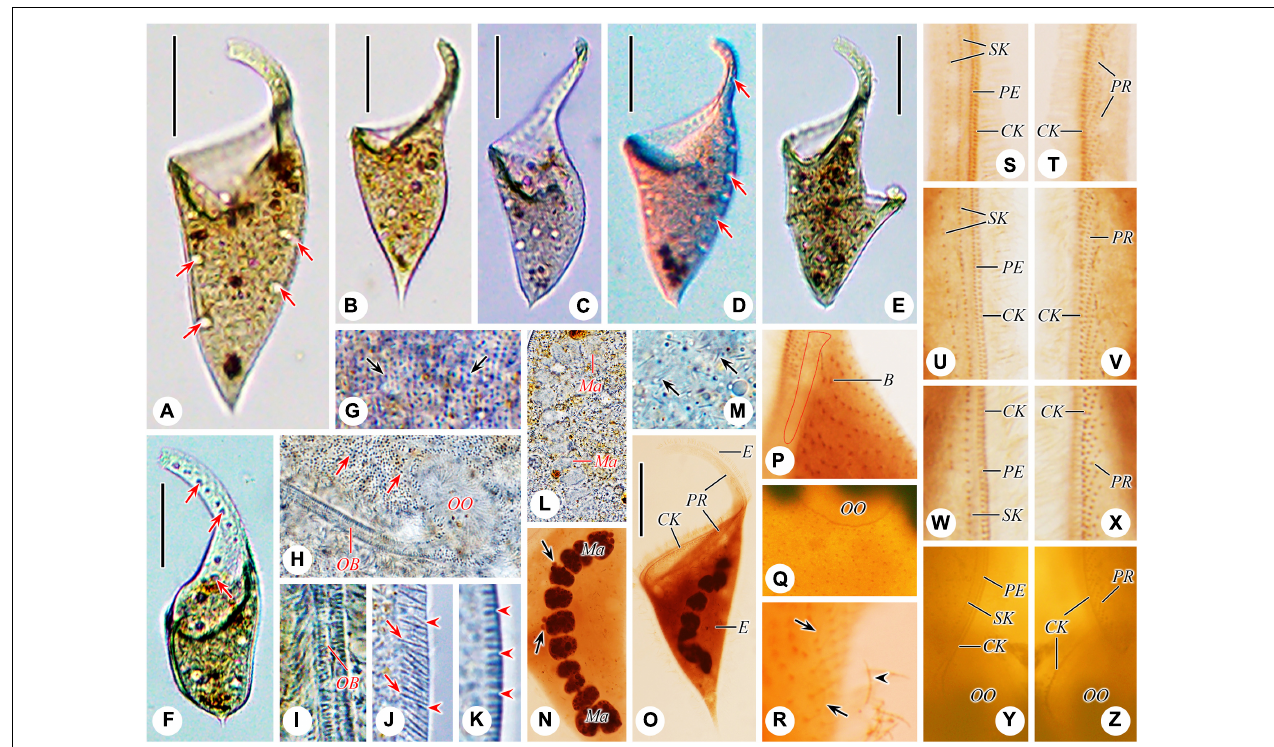
FIGURE 5 | Photomicrographs of Paradileptus conicus from life (A–M) and after protargol staining (N–Z) . (A–D) Various individuals to show different body shapes, arrows indicate the contractile vacuoles. (E) Cell undergoing binary fission. (F) A squashed cell to show the numerous contractile vacuoles (arrows mark three of these). (G) Cortical granules (arrows) underneath the pellicle. (H) Detail of oral region showing the densely arranged cortical granules (arrows). (I) Detail of the proboscis oral bulge. (J) Tangential optical section of the proboscis to show the rod-shaped type I extrusomes (arrows) and oblong type II extrusomes (arrowheads). (K) Tangential optical section of the cortex to show the oblong cortical granules (arrowheads). (L,N) Detail of the macronucleus and micronuclei (arrows). (M) Developing extrusomes scattered in the cytoplasm (arrows). (O) Dorsal view showing the circumoral kinety, developing extrusomes and preoral kineties. (P,R) Detail of the posterior portion of the proboscis; red circle indicates the glabrous area; arrows indicate the monokinetidal tails of dorsal brush with bristles; arrowhead marks a somatic cilium. (Q) Showing the loosely arranged somatic kinetosomes. (S–Z) Right (S,U,W,Y) and left (T,V,X,Z) views of the anterior ( S,T from the same cell), middle ( U,V from the same cell), and posterior ( W,X from the same cell) regions of the proboscis, and proximal portion of oral apparatus ( Y,Z from the same cell). B, dorsal brush; CK, circumoral kinety; E, extrusomes; Ma, macronucleus; OB, oral bulge; OO, oral opening; PE, perioral kinety; PR, preoral kineties; SK, somatic kineties. Scale bars = 60 µ m (A,C–E) , 50 µ m (B,F,O)